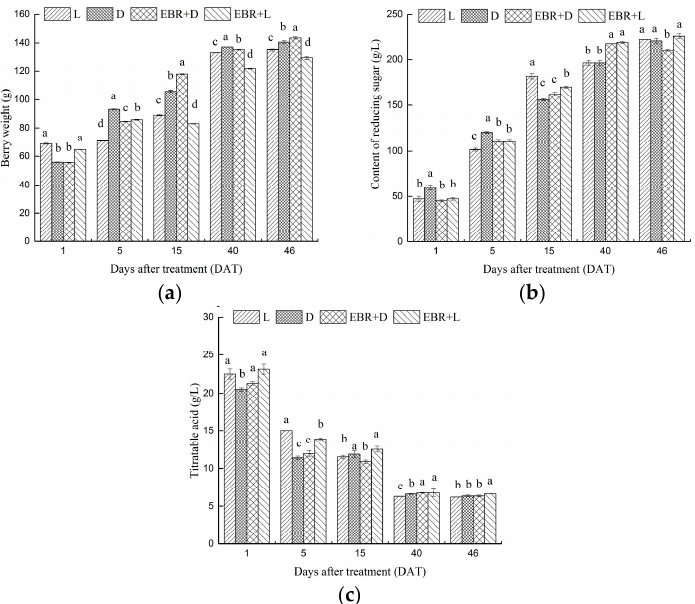
Figure 2. Effects of the four treatments on 100-berry weight ( a ); reducing sugar ( b ) and total acidity ( c ) in grape berry during fruit development. Data represent the mean of three replicates ± standard deviation (error bars). The different letters (a, b, c, d) indicate significant differences between treatments at p < 0.05 (Duncan’s multiple range test). DAT: Days after treatment. The same as belows.